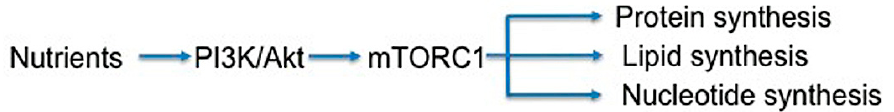
Figure 9. The mTOR-dependent metabolic pathway.